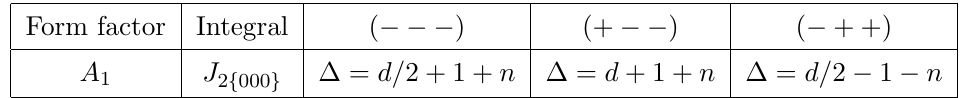
Table 3 . Singularities arising for h T (cid:22)